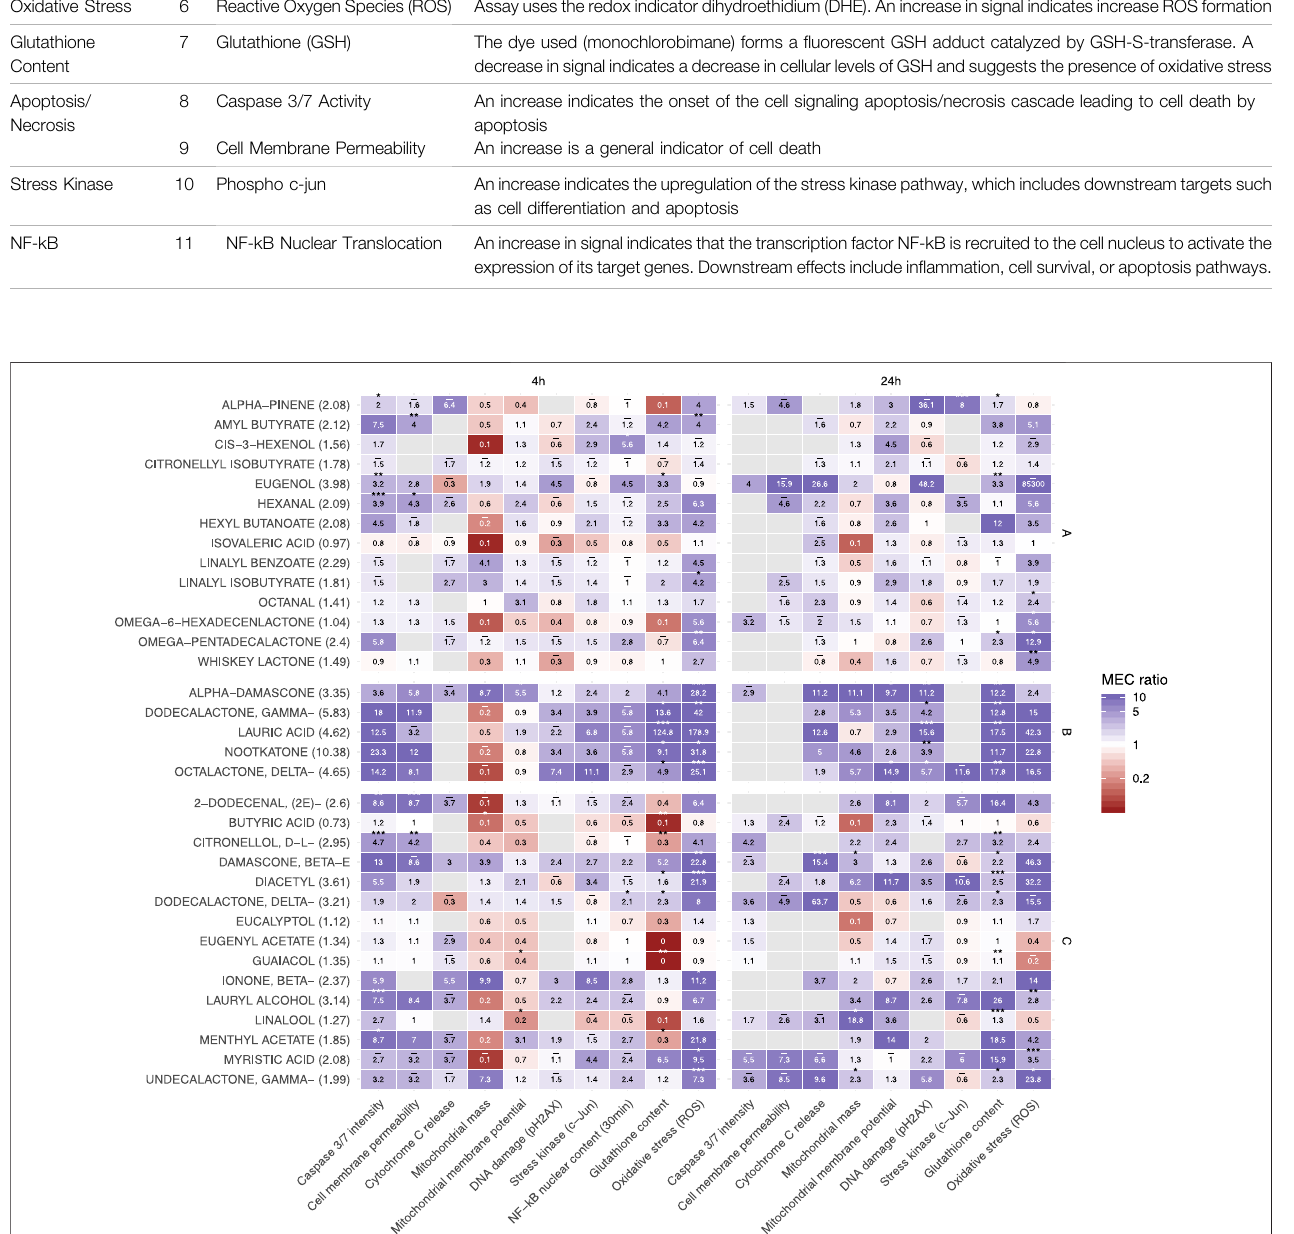
Frontiers in Toxicology |